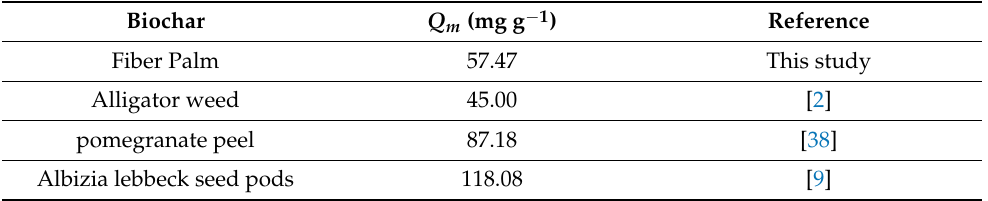
Table 3. Comparison of maximum adsorption capacity of CPX using biomass-derived adsorbents.